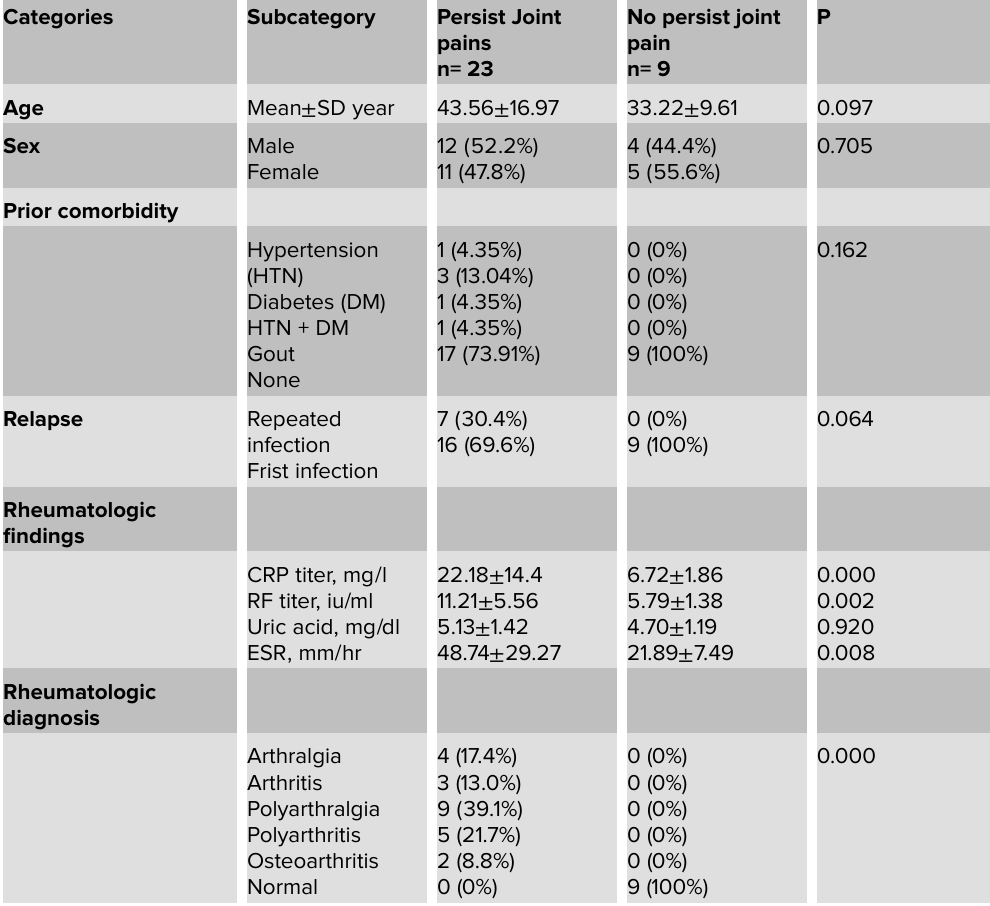
TABLE 1: Baseline characteristics of the patients serologically confirmed CHIKV classified according to joint pain